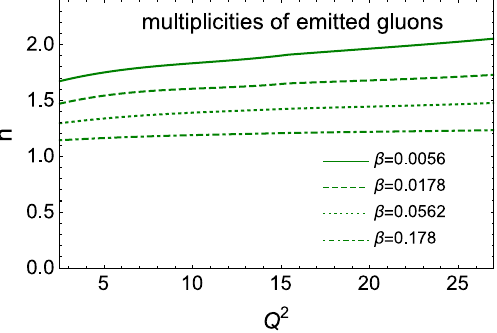
Fig. 4 The average multiplicities of the emitted gluon at different val- ues of β as function of Q 2 using the parameters of the